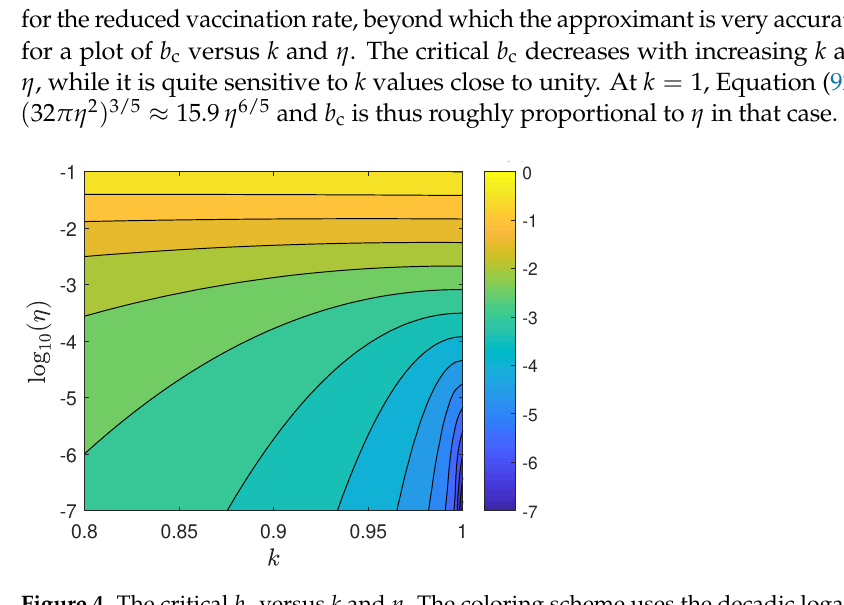
Figure 4. The critical b c versus k and η . The coloring scheme uses the decadic logarithm of b c , and the vertical axis is also logarithmic. Only a relevant range of k values is